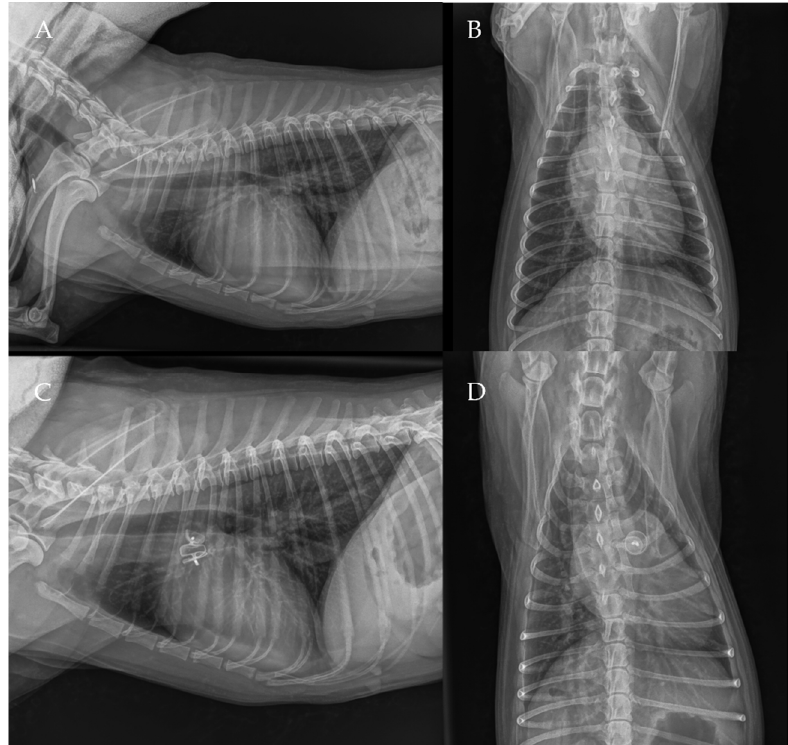
Figure 10. Pre- ( A ) and post-procedure ( B ) right lateral thoracic radiographs of Case 4.